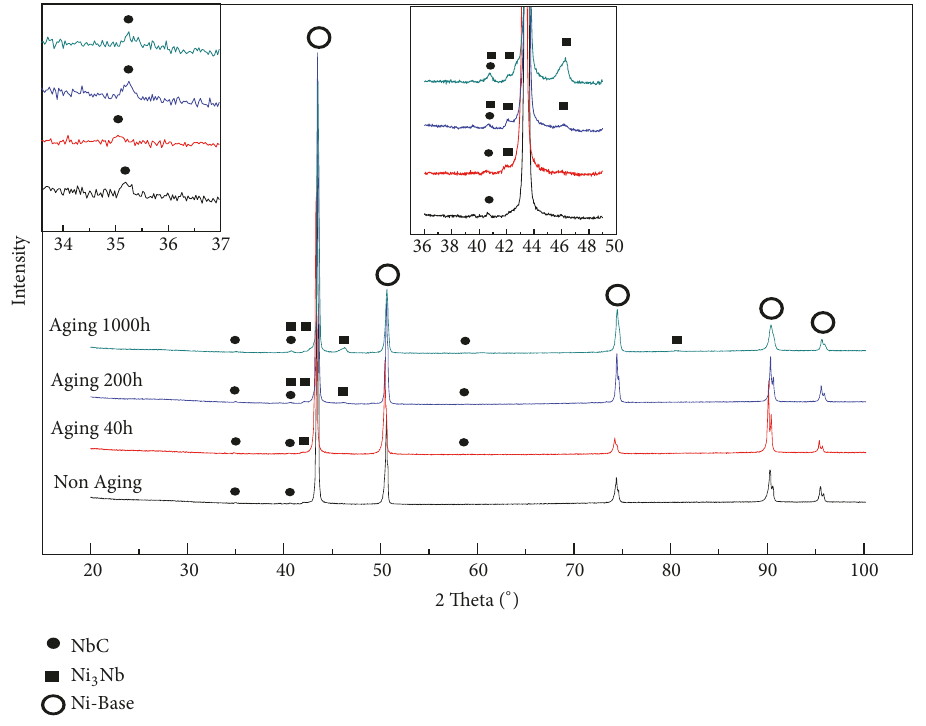
Figure 4: XRD profiles of Alloy 625 after aging sensitization for different time.